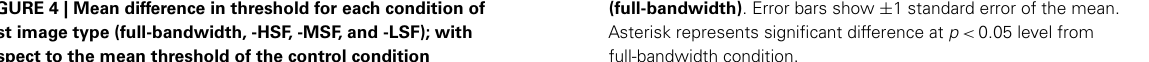
(full-bandwidth) . Error bars show ± 1 standard error of the mean. Asterisk represents significant difference at p < 0.05 level from full-bandwidth